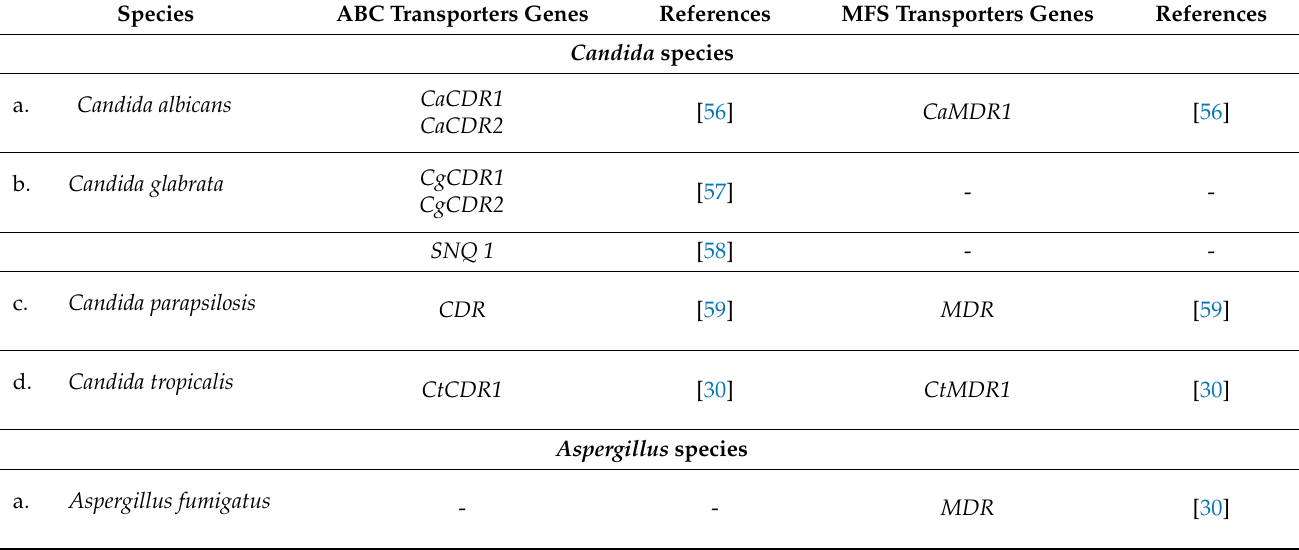
Table 2. Efflux pump encoding genes in fungal